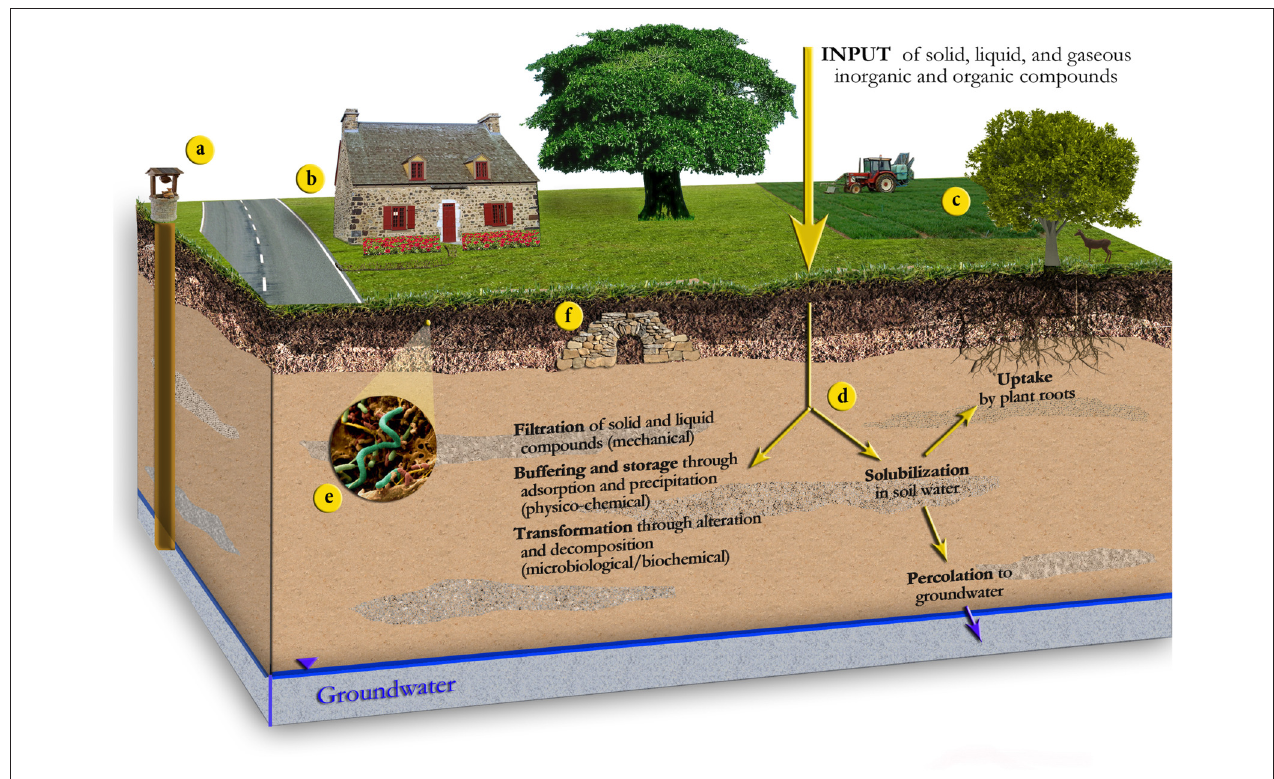
FIGURE 1 | Schematic illustration of the different functions of soils according to Blum’s (1988) classification. The six categories of soil functions correspond, respectively, to (a) the extraction of raw materials and water, (b) physically supporting buildings and other man-made structures, (c) the production of biomass, (d) filtration, buffering, storage, and chemical/biochemical transformations, and (e) the preservation of biodiversity or potentially useful genetic material, as well as of geogenic and cultural heritage. (Original drawing by P.